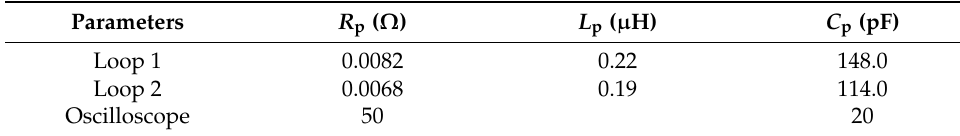
Table 1. Parasitic circuit